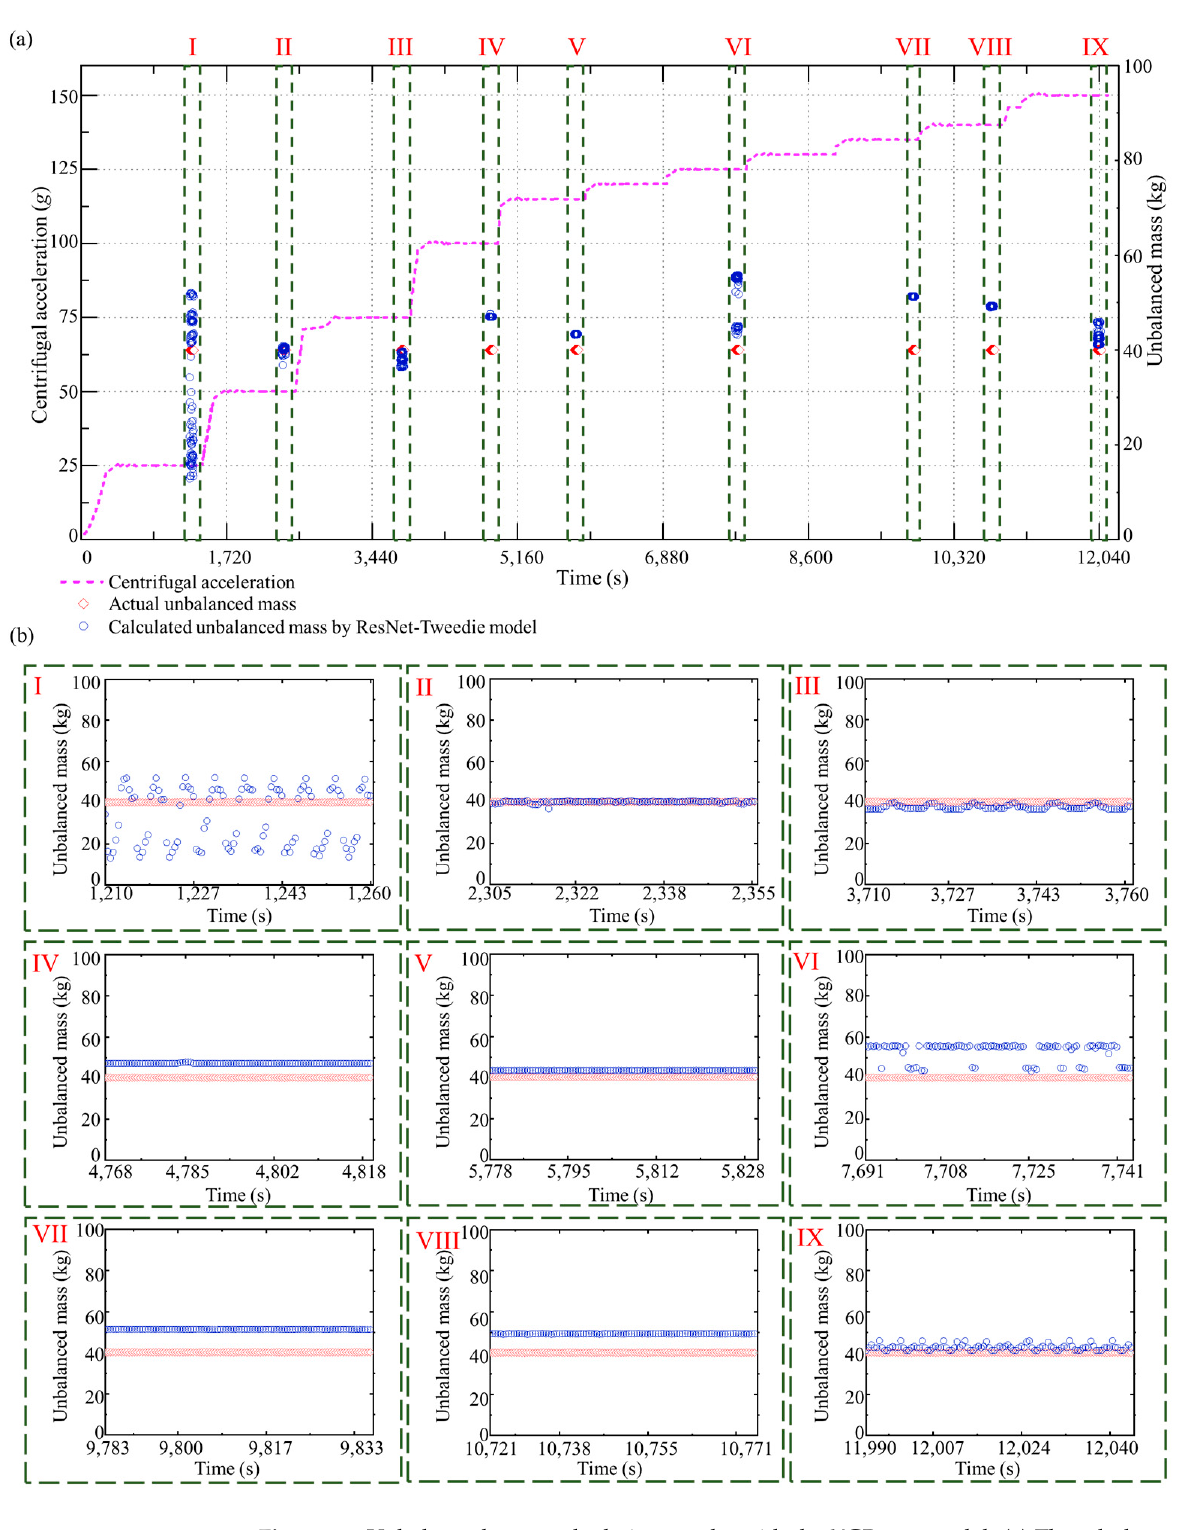
Figure 13. Unbalanced mass calculation results with the XGBoost model. ( a ) The whole speed-up process. ( b ) Identification results during each centrifugal acceleration step.